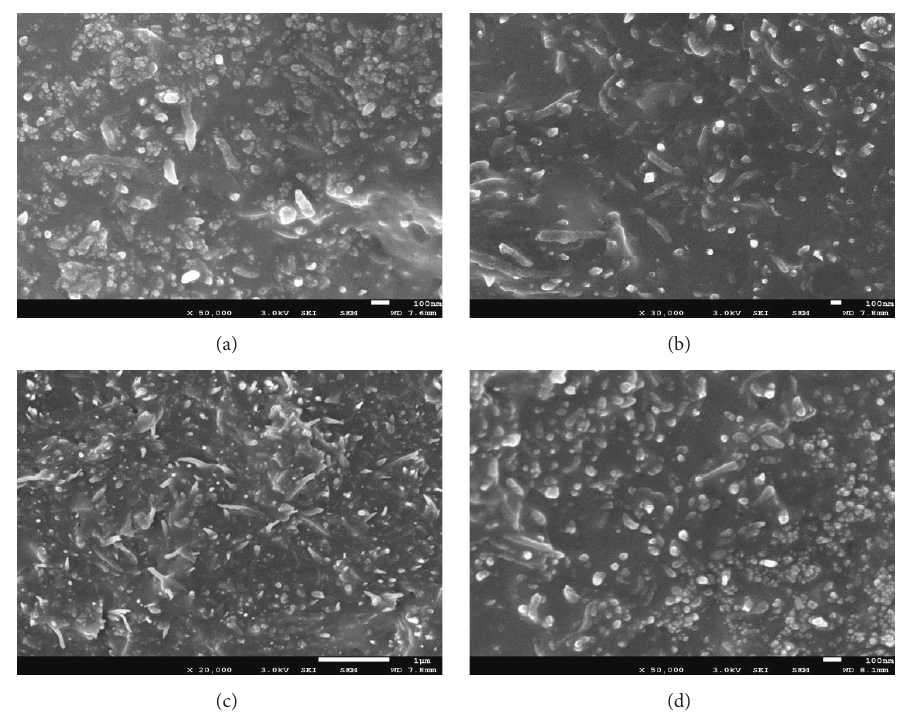
Figure 5: SEM images of NR composites: (a) 6% 0 B 0 h; (b) 10% 1 B 0h; (c) 10% 1 B 2.5 h; (d) 10% 2 B 2.5